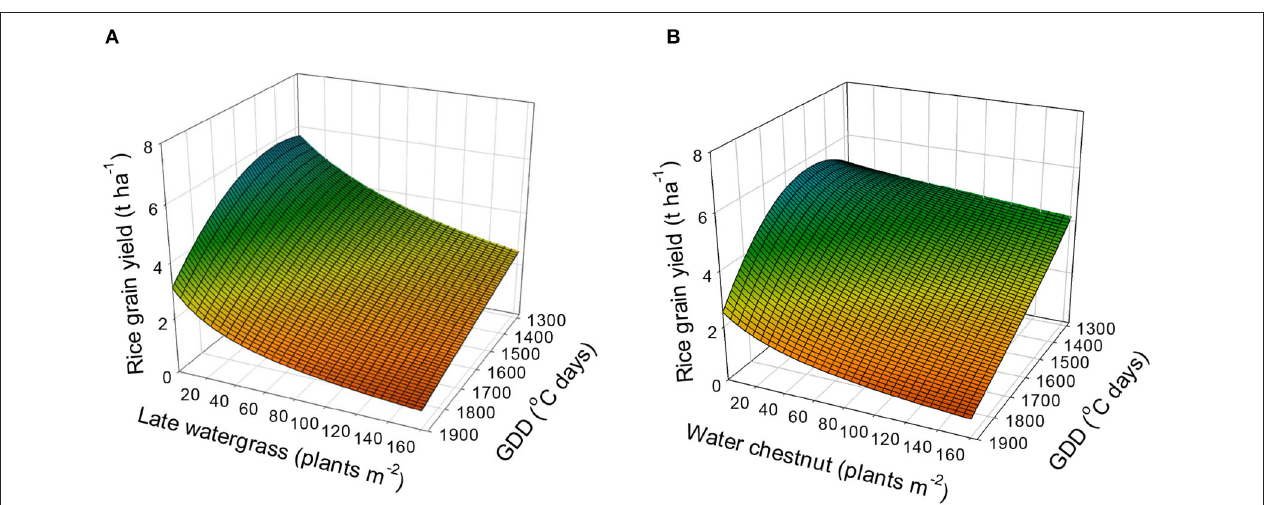
FIGURE 6 | Predicted rice grain yield as a function of the weed density and accumulated growing degree days (GDD; from transplanting to flowering, 89 days) under late watergrass (A) and water chestnut (B) interference and elevated temperature conditions. The mesh is fitted values calculated, using the combined rectangular hyperbolic model (equation 5) and parameter estimates ( Table 4